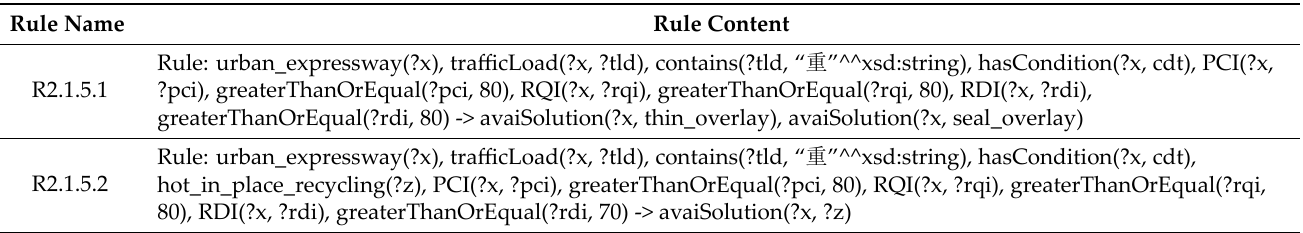
Table 9. Renewal rules for expressways with pavement irregularity and severe traffic